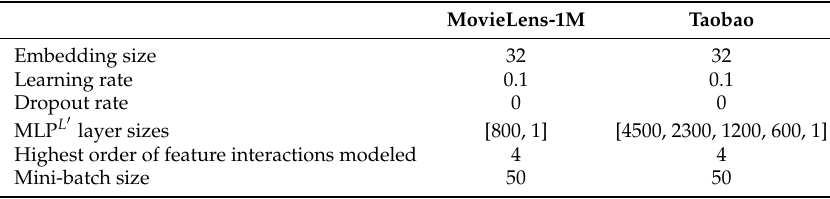
Table 5. Configurations for ALIEN.